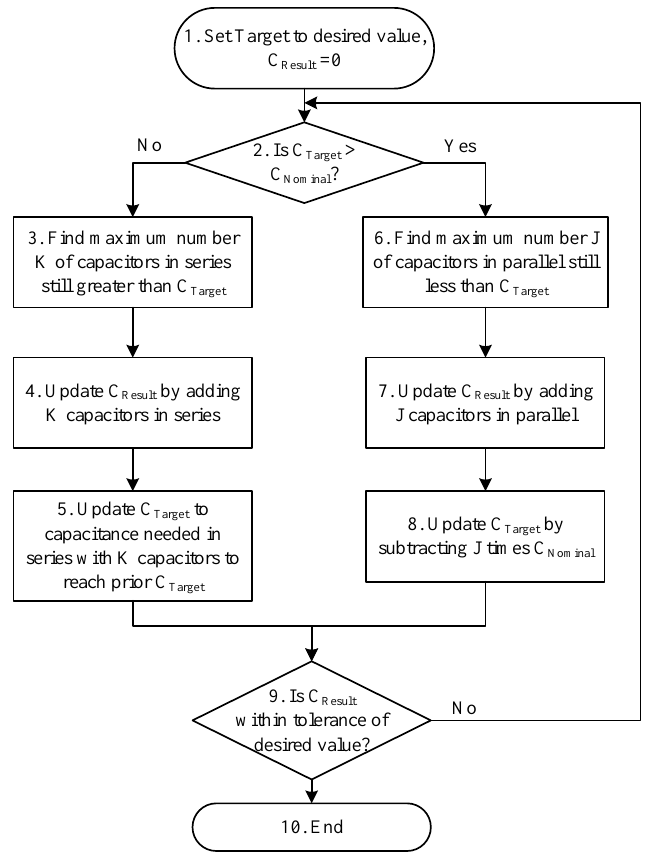
Figure 8. Flow chart of the single-value series/parallel